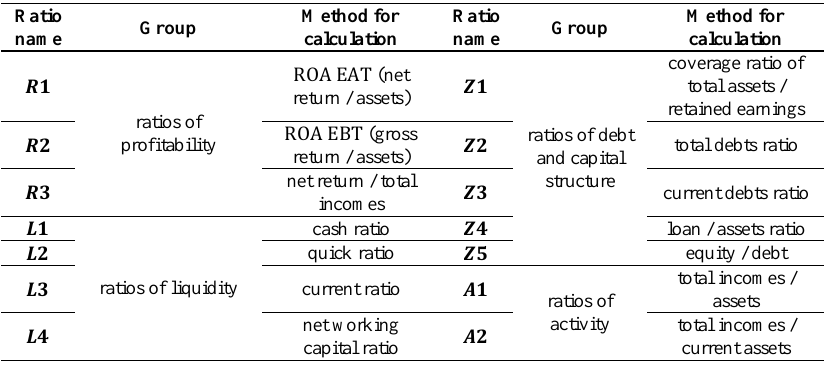
Table 1. Financial ratios used in analysis